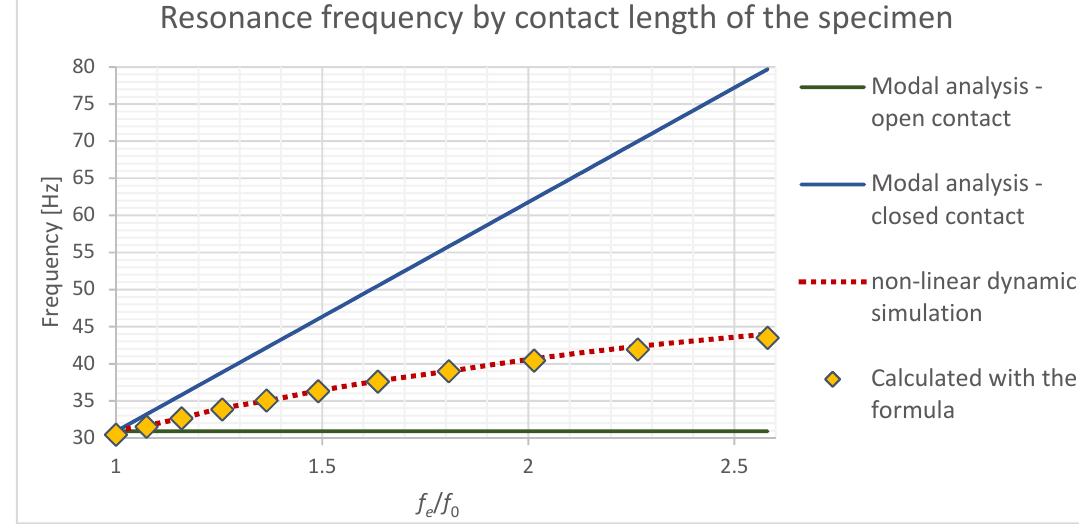
Figure 4. Characteristics of resonance frequency by contact length.